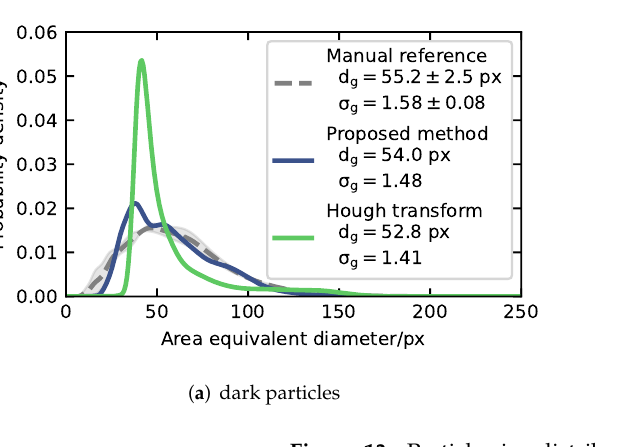
Figure 13. Particle size distributions of dark ( a ) and light ( b ) particles, as predicted by Hough transform and proposed method, compared to averaged manual reference, when being applied to test set. Shaded areas represent ± σ .